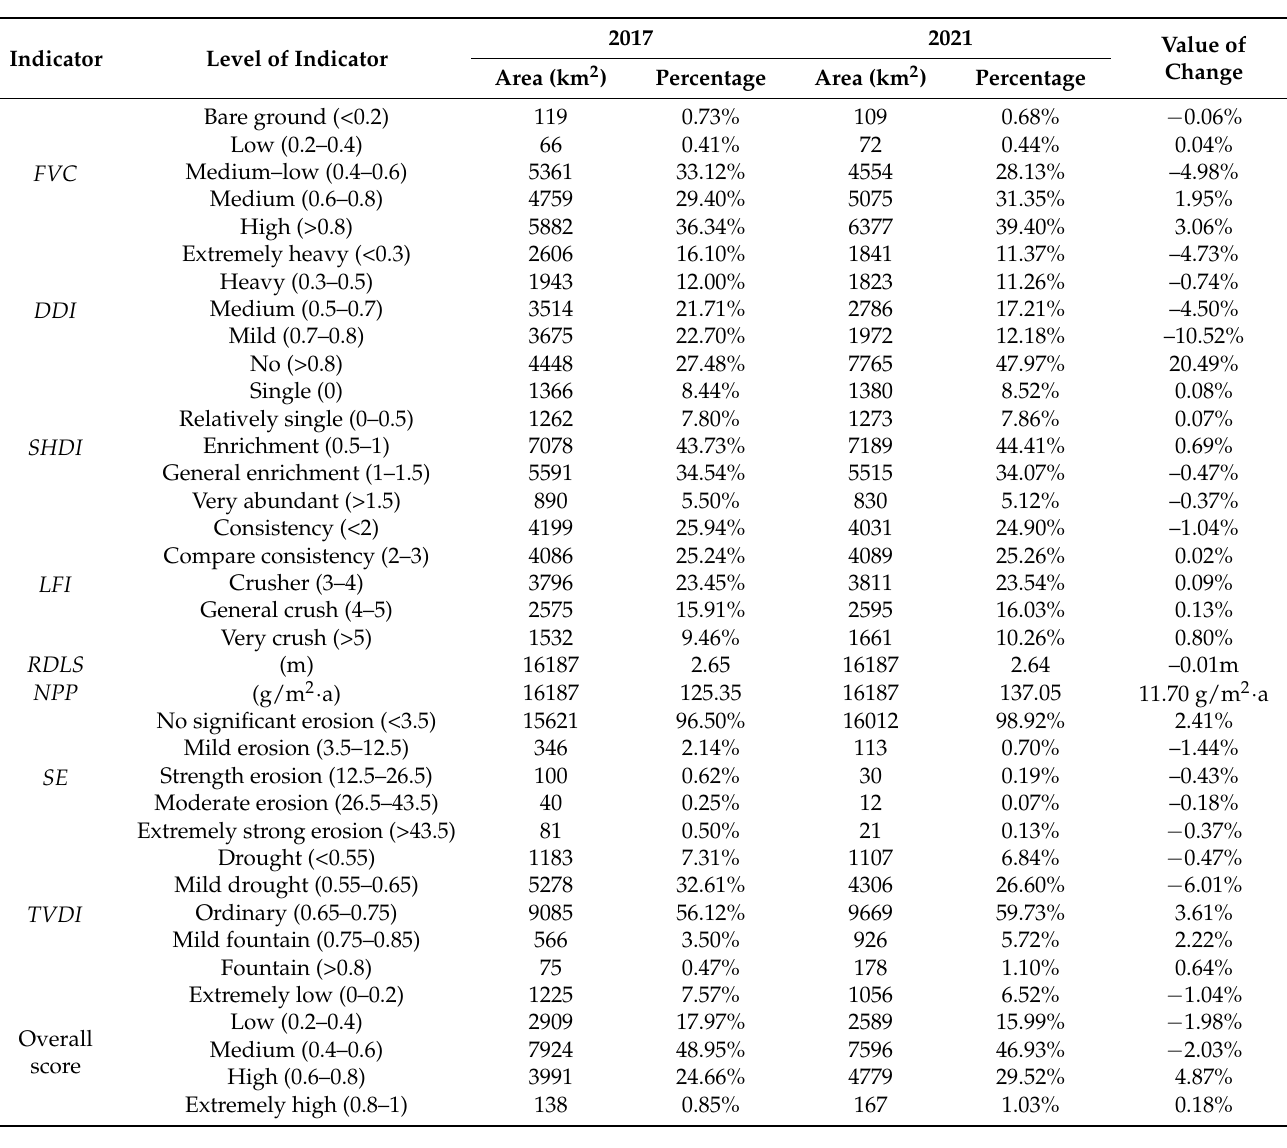
Table 3. List of ecological index values in the Wuliangsuhai watershed.